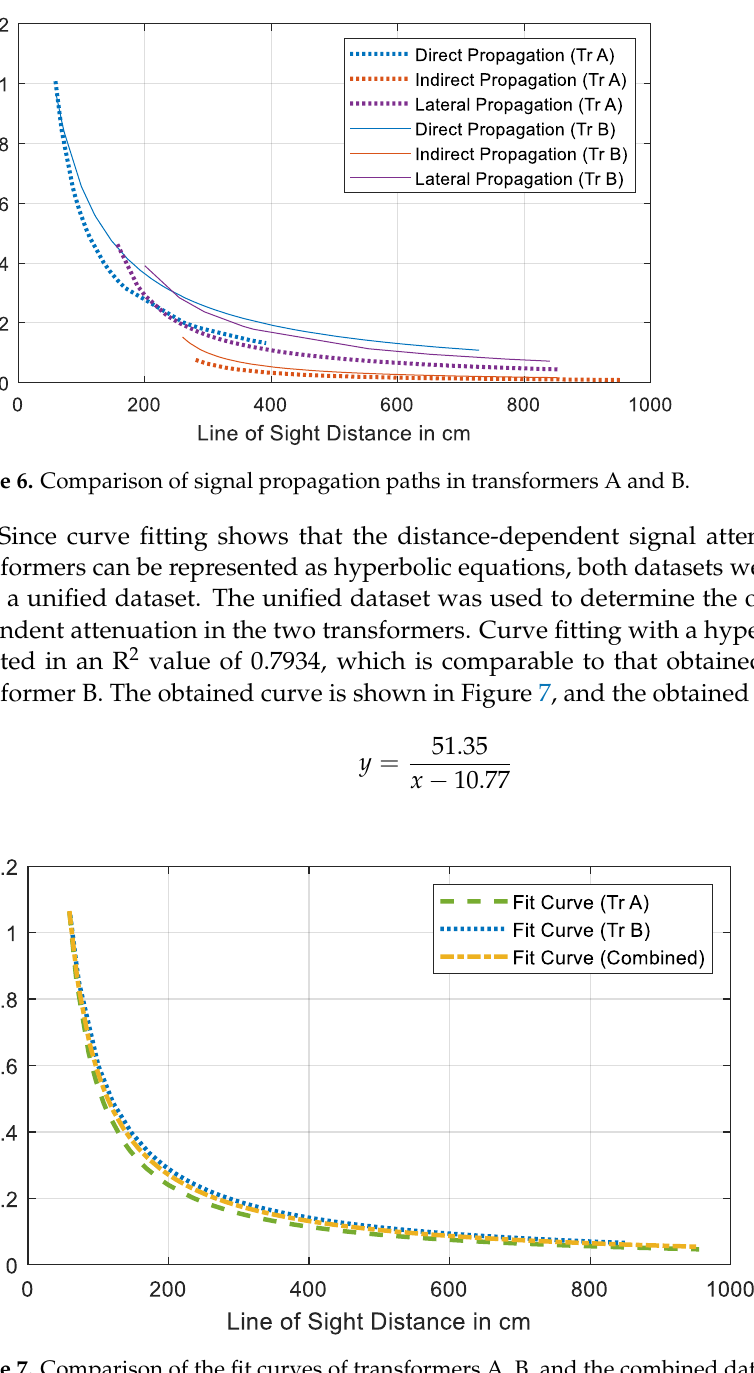
Table 1. Comparison of quantitative parameters between transformers A and B.